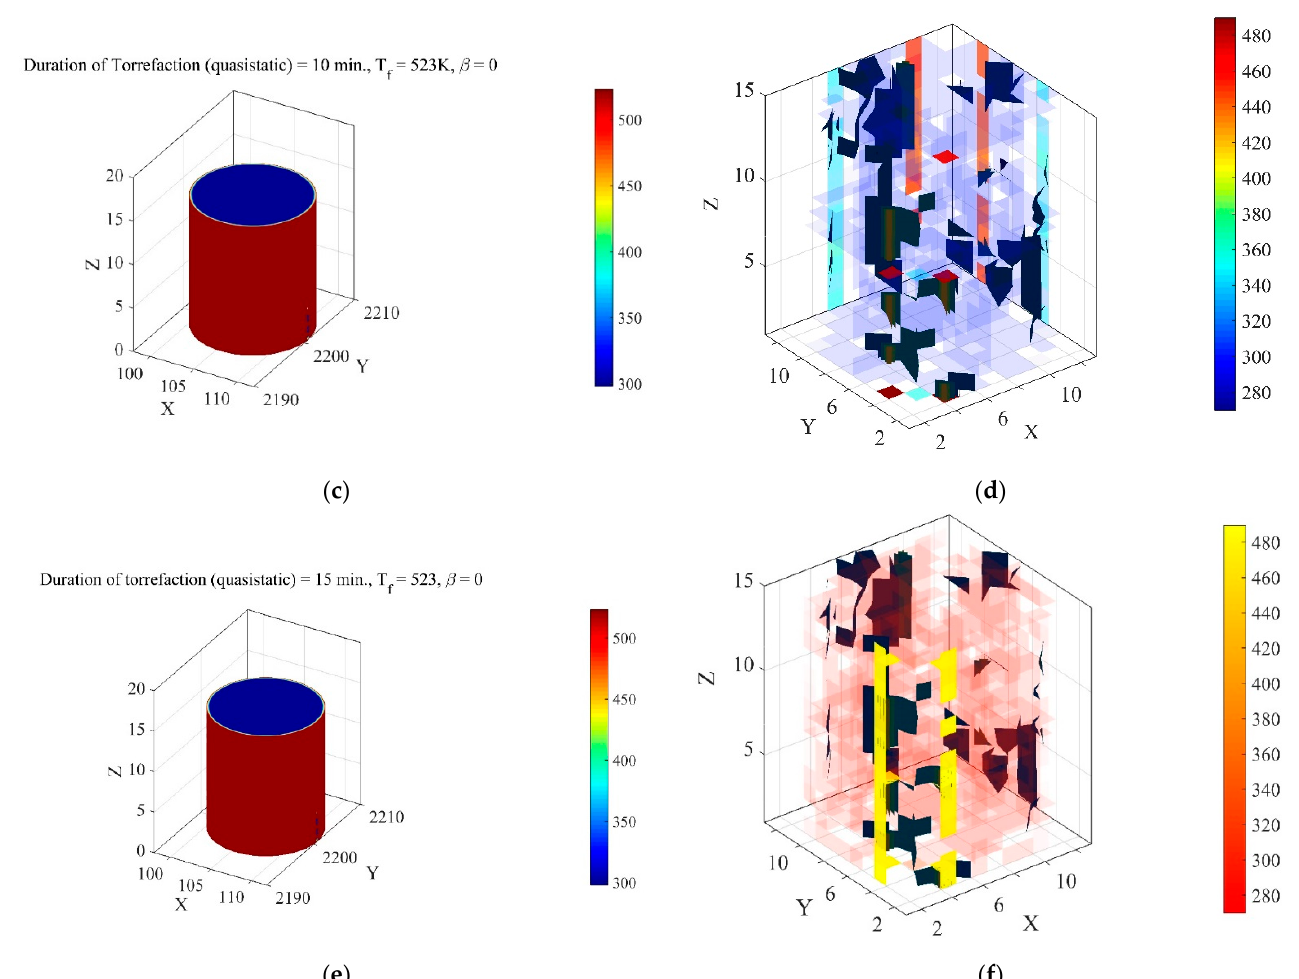
Figure 4. The temperature distribution (quasi-static condition) across a biofuel pellet with arbitrarily chosen heat transfer properties for torrefaction temperature of 523 K ( a ): mesh points, ( b ): interpolated solution, 5 min; ( c ): mesh points; ( d ): interpolated solution, 10 min; ( e ): mesh points; ( f ): interpolated solution, 15 min (g = 0, q = 1.430 W·m − 2 ·K − 1 , k = 3.056 W · m − 1 · K − 1 , Re = 798.85, Pr = 0.0001988).